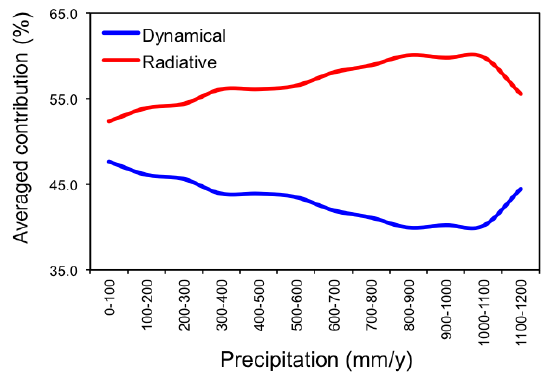
Figure 5. Contributions of dynamically induced (blue) and radia- tively forced (red) temperatures to the raw temperature as a function of annual precipitation in the cold season from 1902 to 2011 over east Asia.